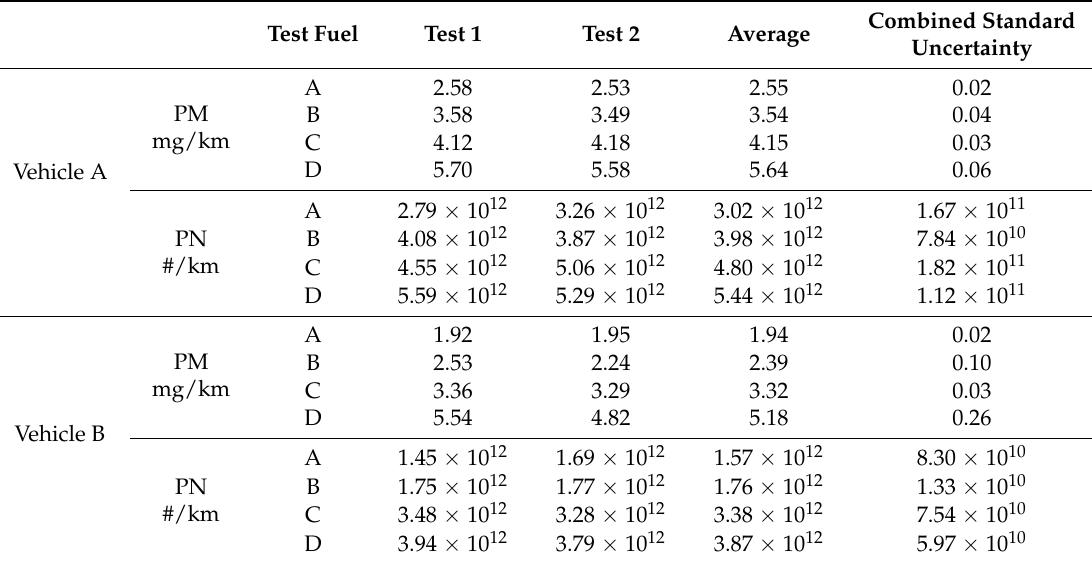
Table 4. Test results and uncertainties in